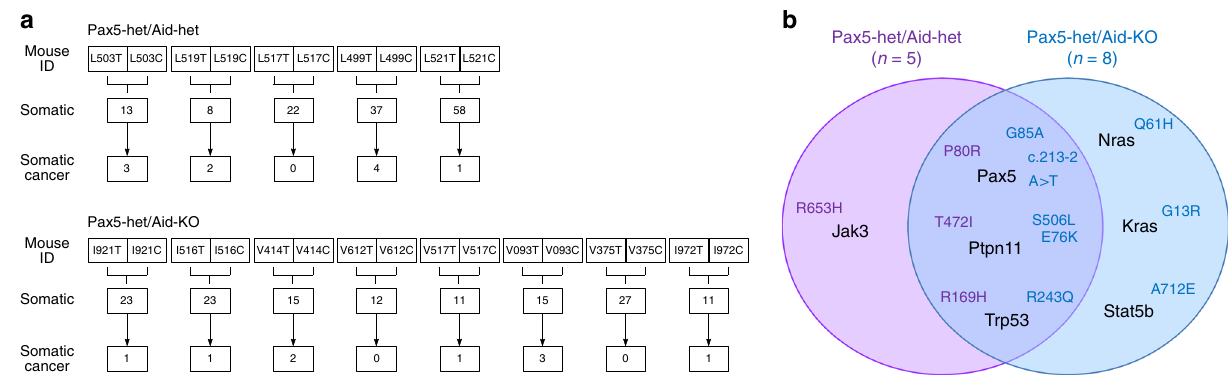
Fig. 2 Mouse tumor exome sequencing in Pax5-het/Aid-het mice and Pax5-het/Aid-KO native B-ALL. a Whole-exome sequencing analysis of tumor and control samples. Tumor-speci fi c somatic mutations were determined by mutect and varscan analysis. The number of somatic cancer genes were calculated by using the cancer gene consensus list. b Genomic comparison between mutations driving native B-ALL as a result of natural infection exposure of Pax5- het/Aid-het (violet) and Pax5-het/Aid-KO mice (light blue), respectively, showed that similar second hits were affected by recurrent the COSMIC decomposition, and S C (original, de novo) = 0.96